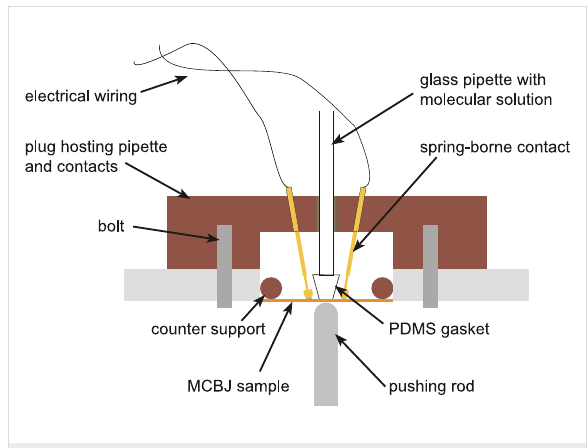
Figure 6: Break-junction setup for use in liquid environment. A PDMS- sealed glass pipette, in which the molecular solution circulates, is pressed onto the central part of the MCBJ chip with the help of a plug screwed to the sample holder. The electrical contacts are realized in this case through spring-borne contacts outside the